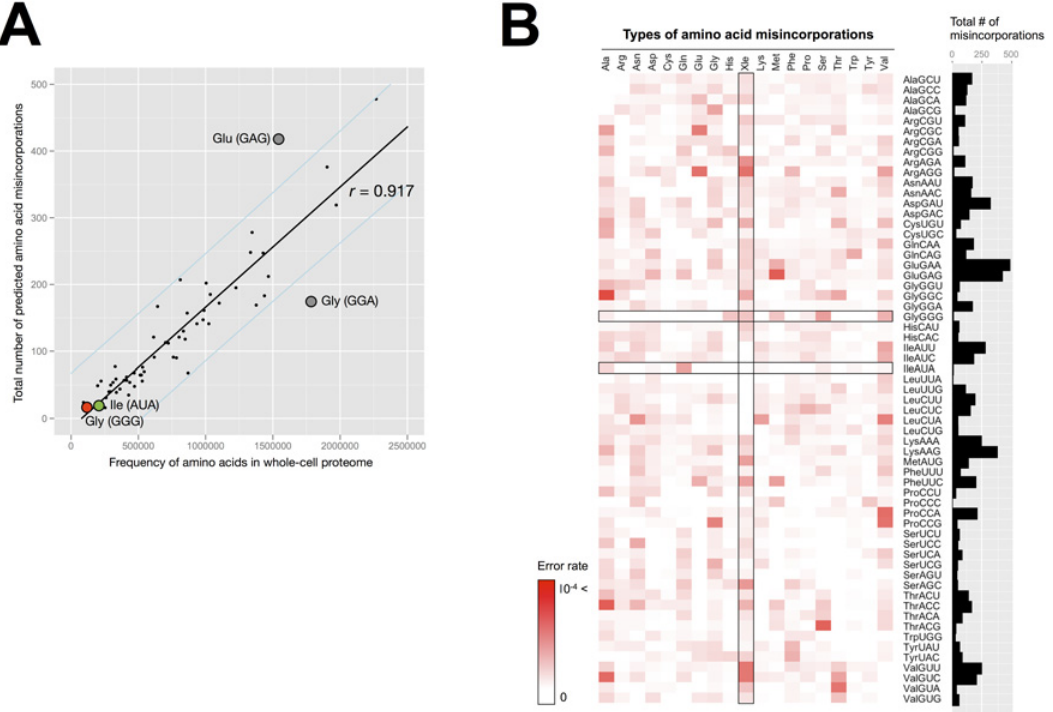
Figure 4. Distribution of amino acid misincorporations predicted in the whole-cell proteome of C. elegans . (A) Scatterplot of the frequencies of amino acids contained in all nonredundant peptides identified with a normal database search (x-axis) versus the total number of predicted amino acid misincorporations (y-axis) for each codon. The black line in the center denotes the linear regression line. The outer, light blue lines denote the 95% confidence interval for an individual predicted value. The red and green dots correspond to the GGG and AUA codons, respectively. The dots located outside the 95% confidence interval are shown in gray. (B) Heat map indicating the degree of predicted amino acid misincorporation (error rate) for each codon. The error rate was predicted by calculating the abundance of misincorporated amino acids relative to the total number of amino acids contained in the whole proteome. The matrix plots in the Gly (GGG) and Ile (AUA) row and in the ‘ Xle ’ (i.e., Ile or Leu) column are boxed. The total numbers of predicted misincorporations for each codon are indicated as a bar chart.